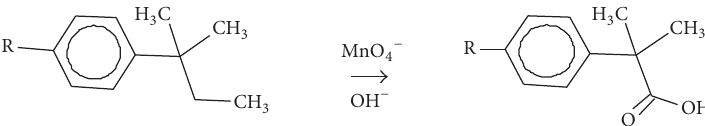
∘ C and NaOH 0.26 mol L